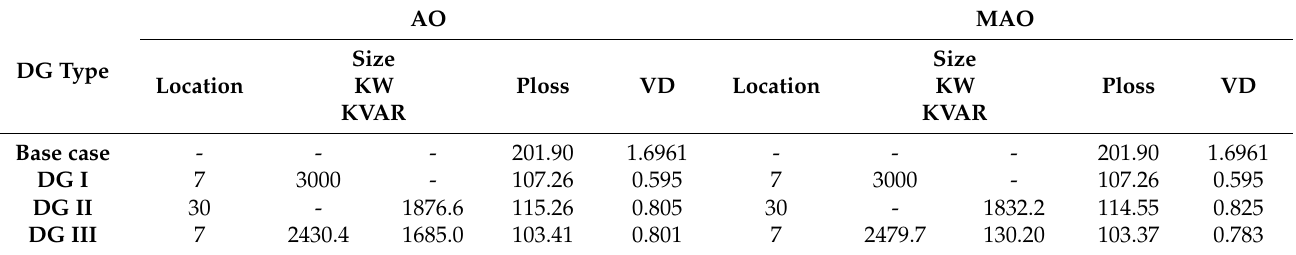
Table 15. Case 3: optimal DG allocation based on loss minimization and voltage deviation.